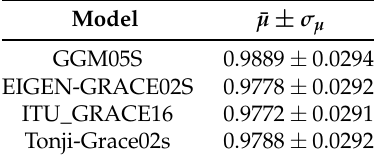
Figure 8. Distribution of the results for the Lense-Thirring parameter µ after 50,000 random permutations. The Gaussian fit for each of the gravitational fields considered in our analyses are shown. Table 5. Results for the Lense-Thirring parameter after the Gaussian fit described in the text and based on 50,000 random permutations of the residuals obtained for each 7-day arc from the POD described in Section 6. The error σ µ represents the standard deviation of each Gaussian fit at a 95% confidence